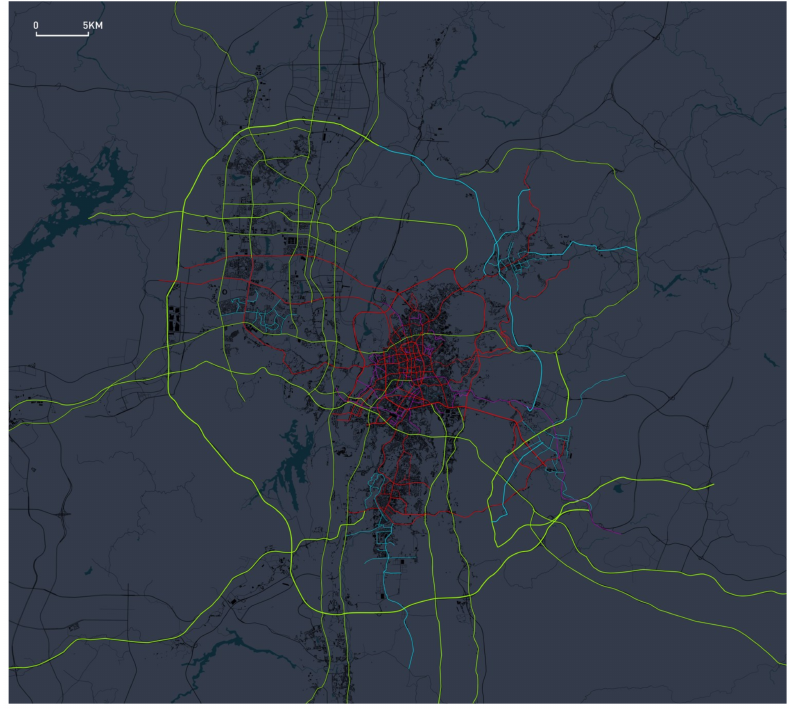
Figure 9. Shape of roads with high occupancy.